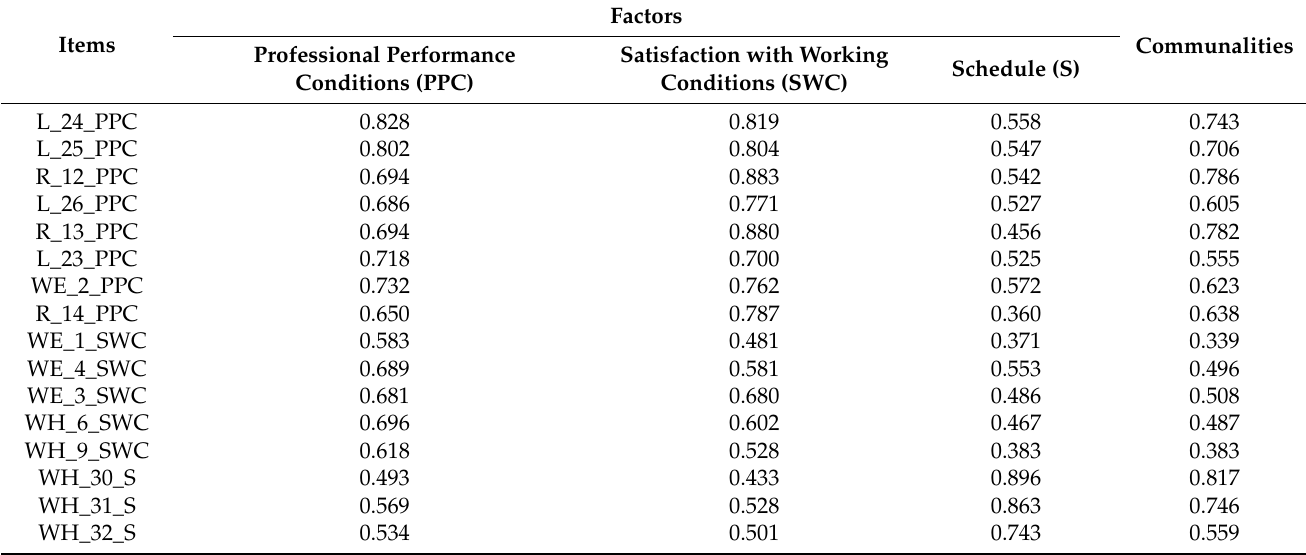
Table 5. Results of the EFA regarding the Scale of Causes of Churning (Final Solution).